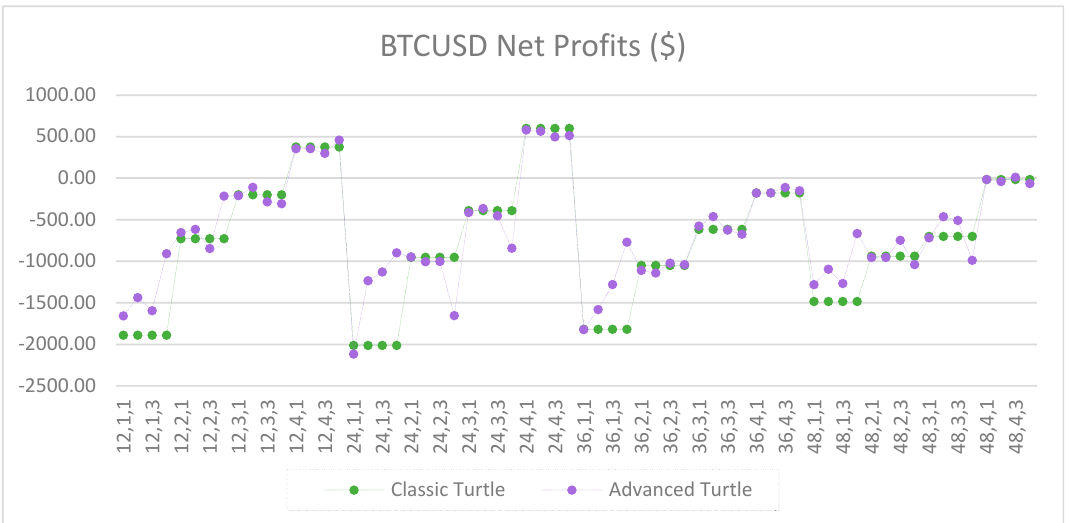
Figure A31. Net profits of BTCUSD between the classic and the advanced Turtle systems for every combination of N, X, Y for the medium parameters (40, 80).